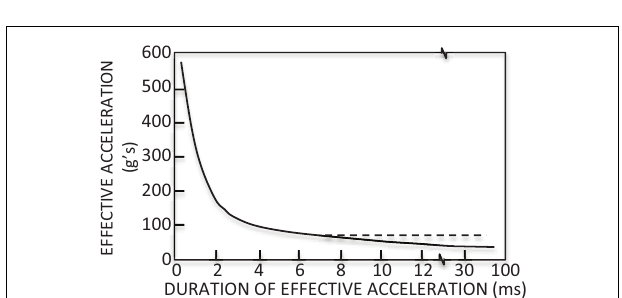
FIGURE 1 | Head forms used in ballistic and blunt trauma testing . (A) NIJ ballistic head form for testing behind armor blunt trauma, constructed of aluminum, with a cavity filled with modeling clay. (B) PEEPsite ballistic head form for testing behind armor blunt trauma, designed out of concern for artifacts created by the vertical petals of the NIJ head form. (C) ISO head form for measuring blunt trauma, used in conjunction with the maximum translational